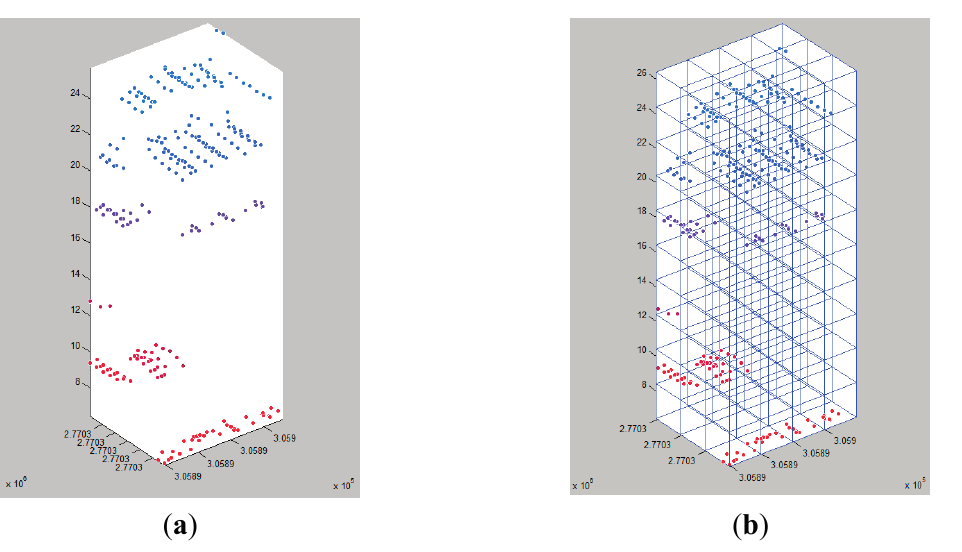
Figure 1. An example of structured points: ( a ) irregular points, ( b ) voxel of